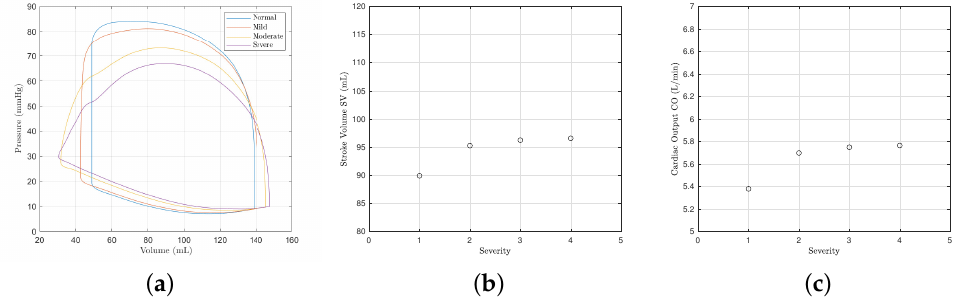
Figure 3. Left ventricle pressure–volume loop, the stroke volume and the cardiac output with different severities of mitral valve regurgitation. The x axis of the SV and CO figures give the severity of regurgition, where 1 denotes normal or control, 2 denotes mild, 3 denotes moderate, and 4 denotes severe. The model parameter values used to model each severity are provided in Table 4. ( a ) Pressure–volume loops. ( b ) The stroke volume. ( c ) The cardiac